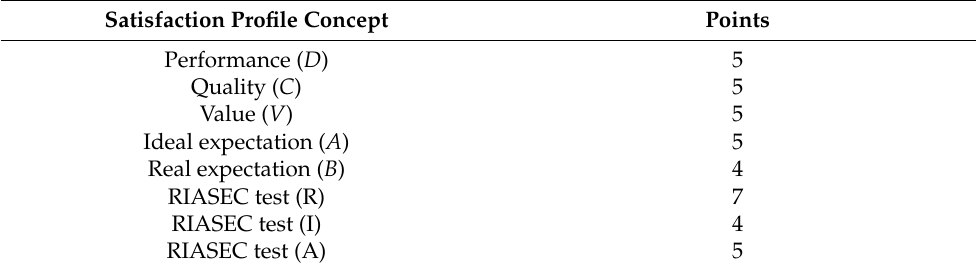
Table 3. A hypothetical score of the satisfaction profile